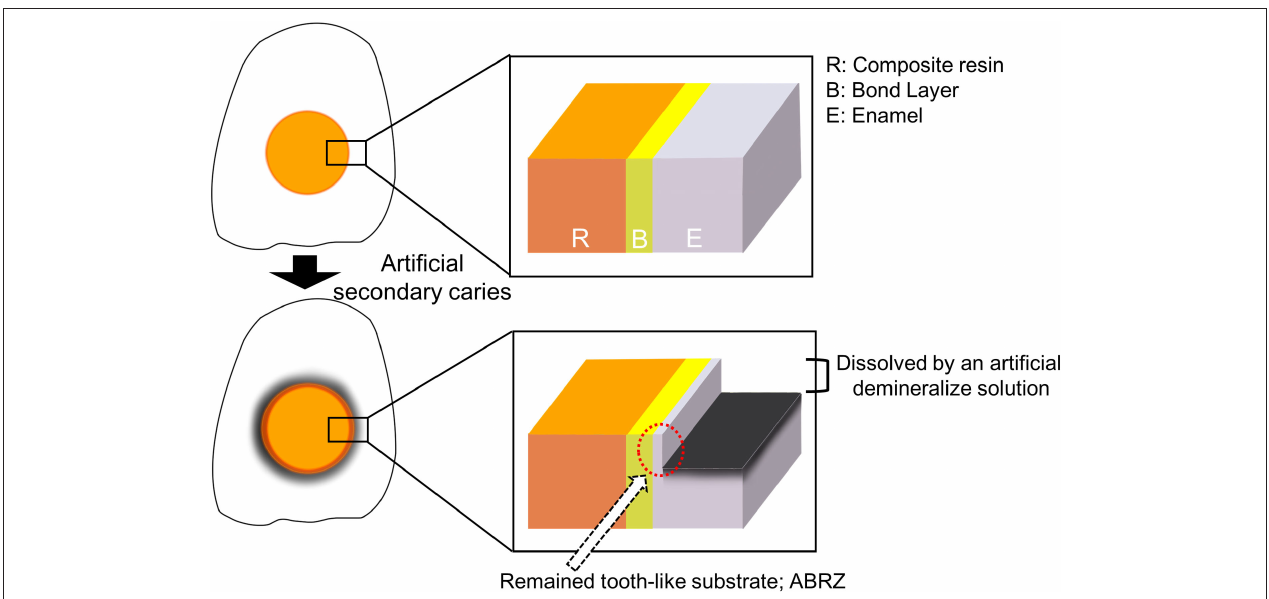
FIGURE 3 | The schematic design of an ABRZ. An ABRZ is observed beneath the bonding interface as a tooth-like substrate despite an artificial demineralize solution dissolves the enamel